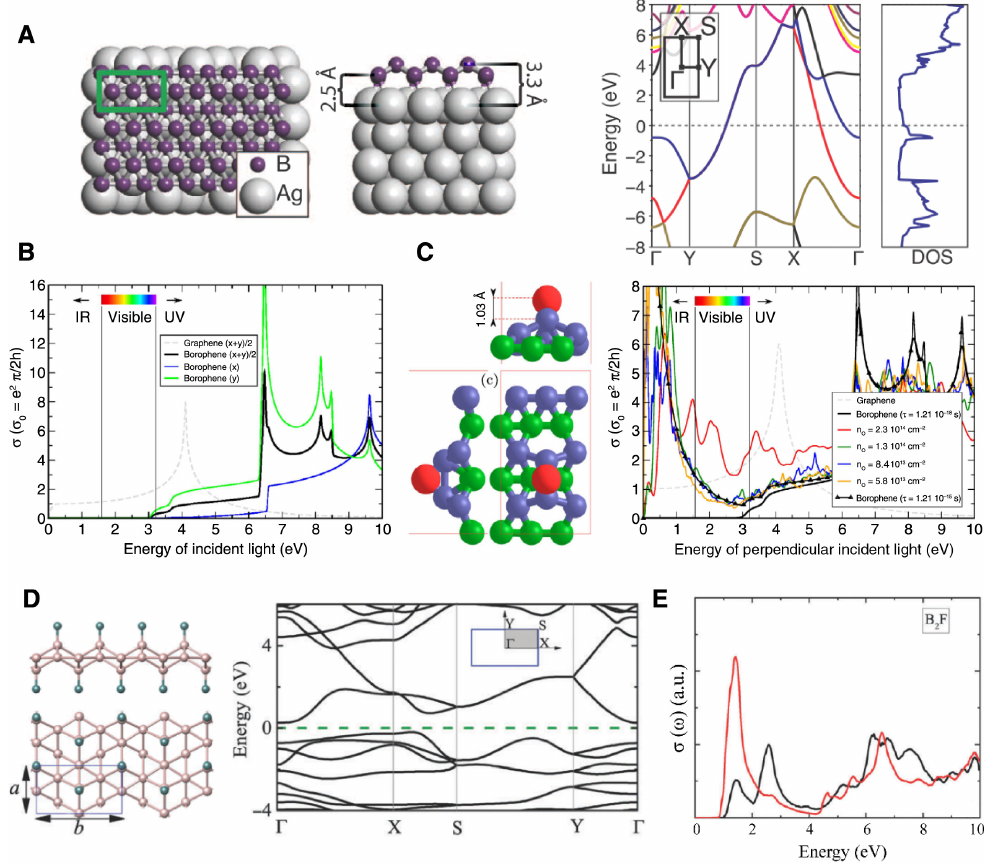
Figure 3: The comparison of geometric and electronic structure for pristine and functionalized borophene. (A) Top: Top and side view of the borophene structure ( Pmmn ) grown on the silver surface. Bottom: The band structure of free-standing borophene. Reproduced with permission [57]. Copyright 2015, American Association for the Advancement of Science. (B) The optical conductivity of pristine borophene along x [100], y [010], and xy [110] directions. (C) Left: Side views and top view of the oxidized borophene configuration. Green and blue spheres indicate boron atoms located at different planes. The red sphere stands for the oxygen adatom. Right: The comparison of optical conductivity of pristine and oxidized borophene. Reproduced with permission [73]. Copyright 2016, IOP Publishing. (D) The atomic configuration and band structure of the fluorinated borophene (BF ). (E) The optical conductivity of the fluorinated 2 borophene (BF ). Reproduced with permission [74]. Copyright 2018, Royal Society of 2